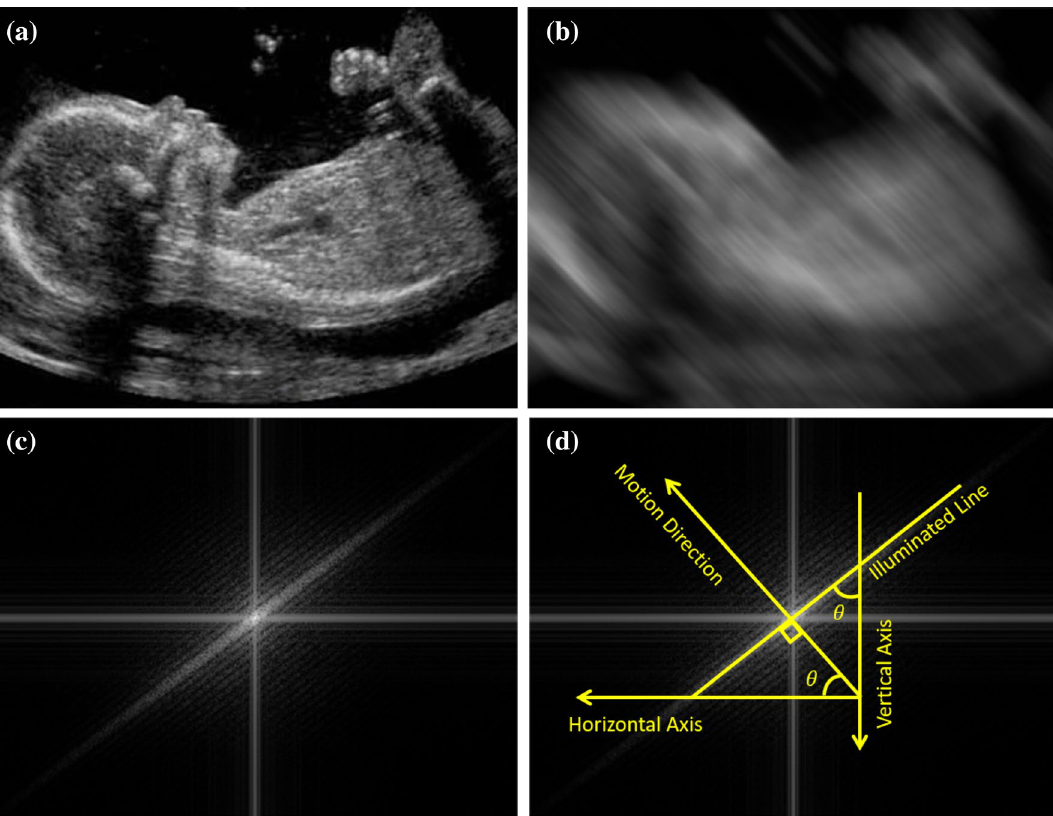
Figure 2. ( a ) Fetus ultrasound image, ( b ) the blurred version of image generated by linear motion, ( c ) Fourier transform of image ( b ), ( d ) the geometrical representation of blur angle θ and linear motion direction shown in ( c